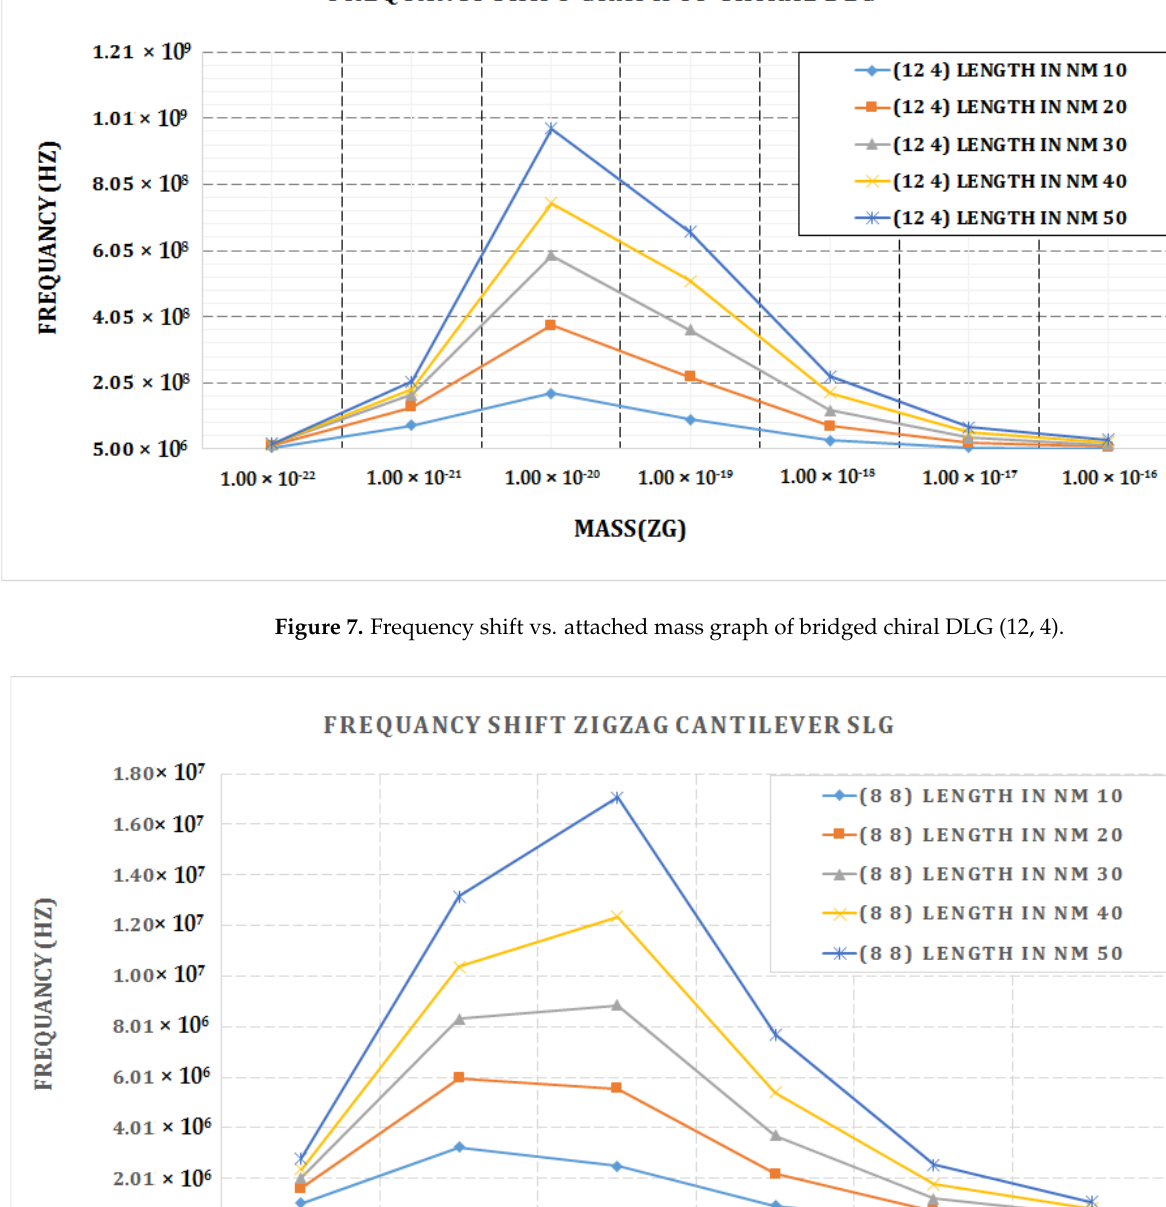
Figure 8. Frequency shift vs. attached mass (Zg) graph of cantilever armchair SLG (8, 8).